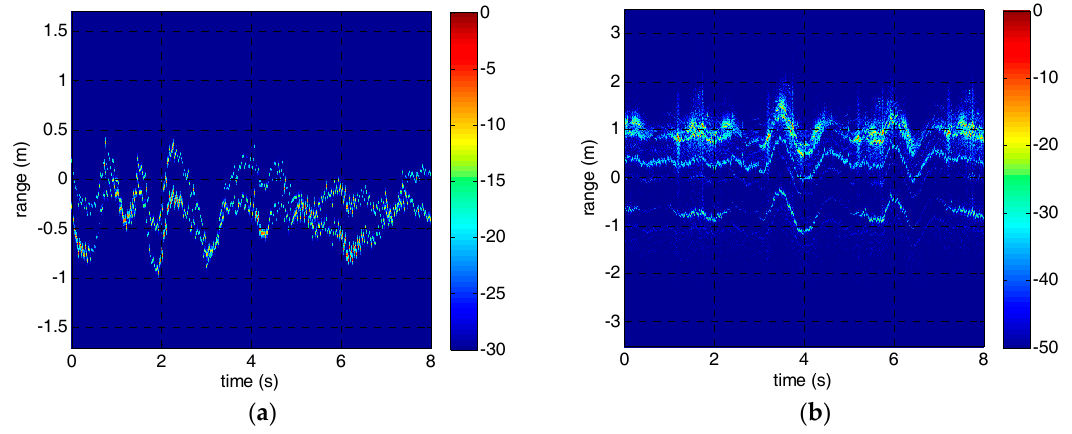
Figure 5. The initial HRRPs of the micro-motion targets. ( a ) The HRRP of the corner reflectors. ( b ) The HRRP of the warhead model.